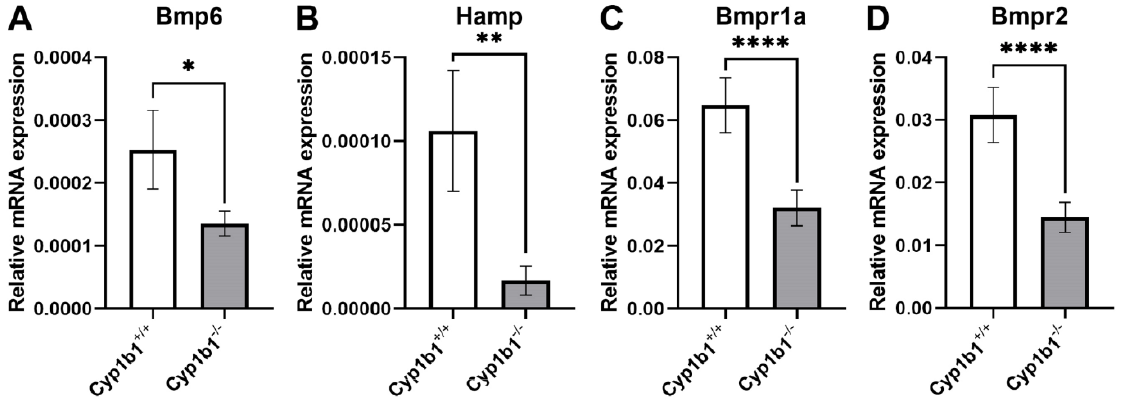
Figure 4. Decreased BMP6 and hepcidin gene expression levels in Cyp1b1 −/− liver sinusoidal endothelial cells (SEC). RNA was prepared from liver SEC isolated from wild-type ( Cyp1b1 +/+ ) and Cyp1b1-deficient ( Cyp1b1 −/− ) mice as previously described by us [43] . qPCR analysis was performed to compare Bmp6 ( A ), Hamp ( B ), Bmpr1a ( C ), and Bmpr2 ( D ) in Cyp1b1 +/+ and Cyp1b1 −/− liver SEC. Samples were conducted in triplicate and repeated twice using different isolations of liver SEC (* p <0.05, ** p <0.01, **** p <0.0001).